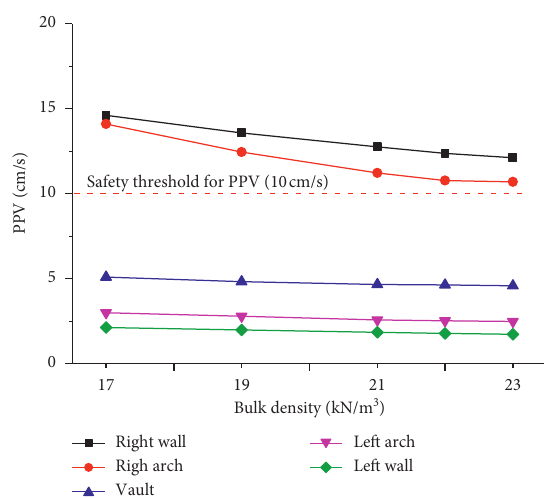
Figure 9: Changes of maximum PPV with bulk density.